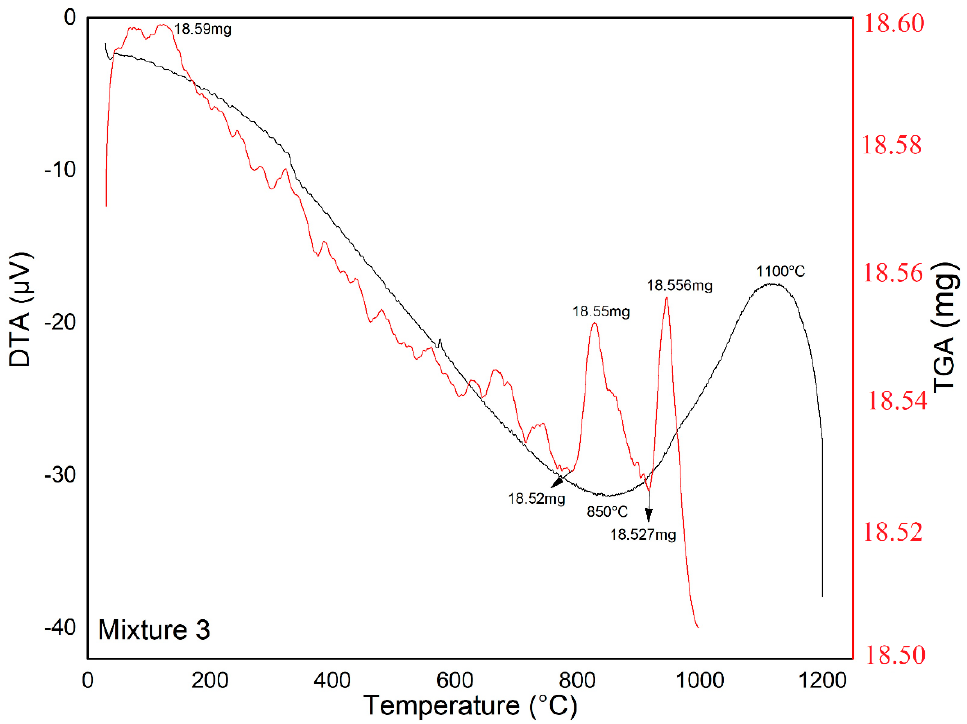
Figure 10. Thermal analysis (DTA-TGA) between 25 and 1200 °C for Mixture 3 showing characteristic temperatures.